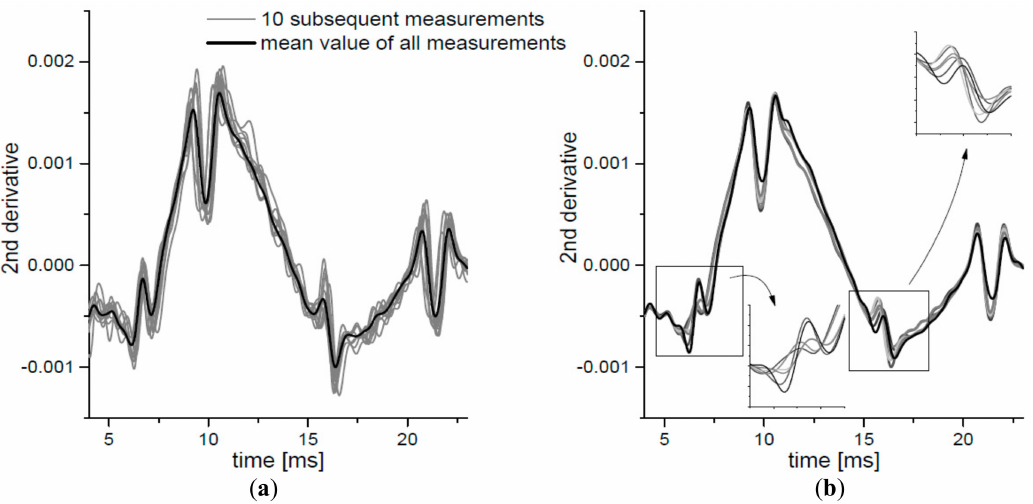
Figure 3. ( a ) The second derivative of the pressure curve for 10 subsequent measurements for one participant (gray lines). The black line is the mean value of 30 measurements for this participant. ( b ) The mean value for 6 participants. See text for detailed description of the